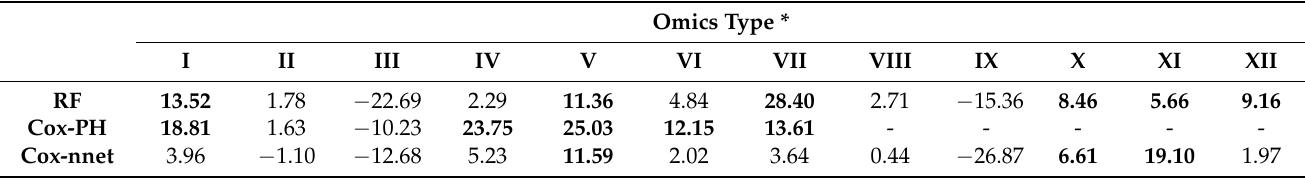
Table 4. Pairwise t-test to validate the statistical significance of improved performance by SurvCNN. A positive test metric (t) denotes the superiority of SurvCNN. Annotations in bold mark the instances where SurvCNN significantly ( p < 0.005) outperforms the competition.